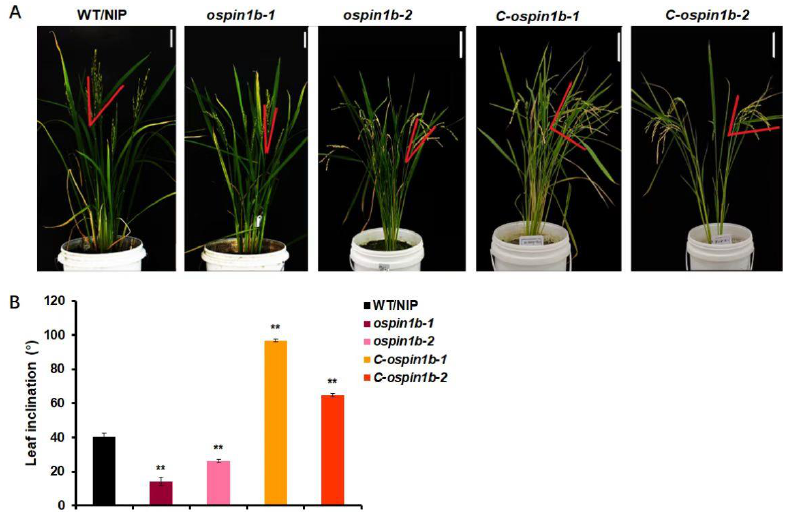
Figure 2. Identification of complementary ospin1b lines. ( A , B ) The phenotype and statistics analysis of flag leaf inclination in WT/NIP, ospin1b-1 , ospin1b-2 , complementary ospin1b lines for 4-month-old, C-ospin1b-1, and C-ospin1b-2 . The angle between the red lines represents the flag leaf inclination. The statistical data are mean ± SD (n = 3) and ** indicates significant differences between WT/NIP, ospin1b-1 , ospin1b-2 , C-ospin1b-1, and C-ospin1b-2 (** p < 0.01; Student’s t -test). Scale bar = 10 cm.